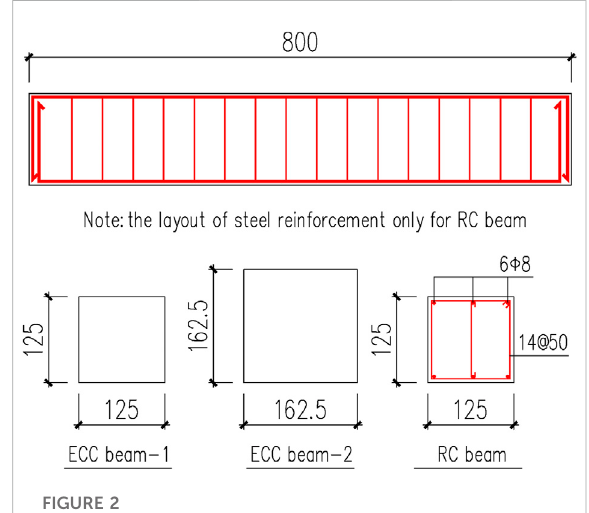
FIGURE 2 Dimensions, size, and reinforcement details of